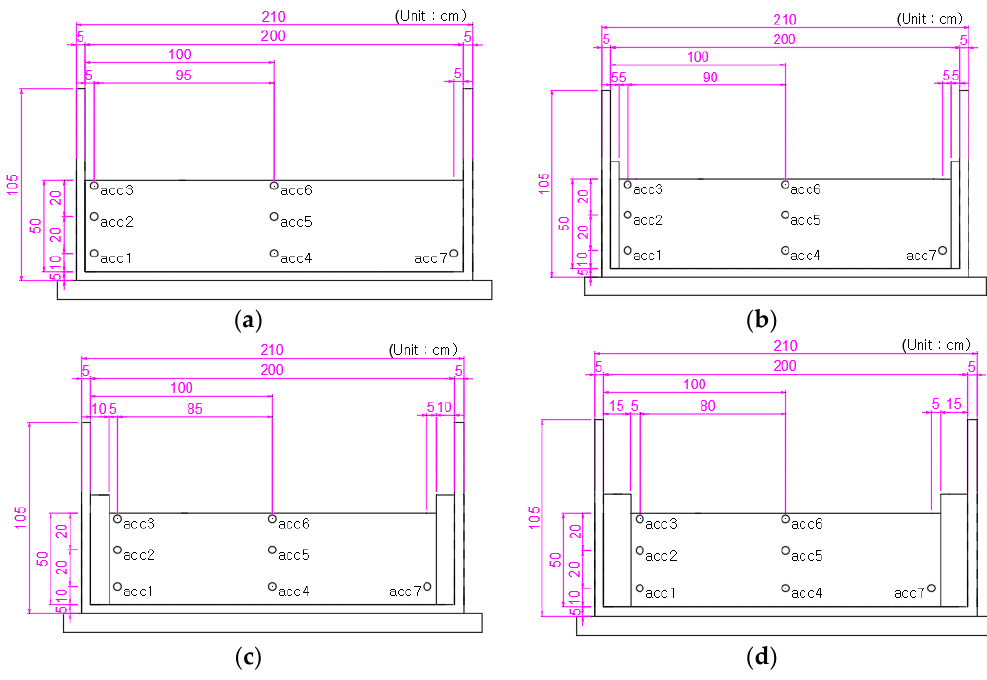
Figure 6. Arrangement drawing of accelerometer: ( a ) Arrangement drawing of Case1, Case 5; ( b ) Arrangement drawing of Case 2; ( c ) Arrangement drawing of Case3; ( d ) Arrangement drawing of Case 4.